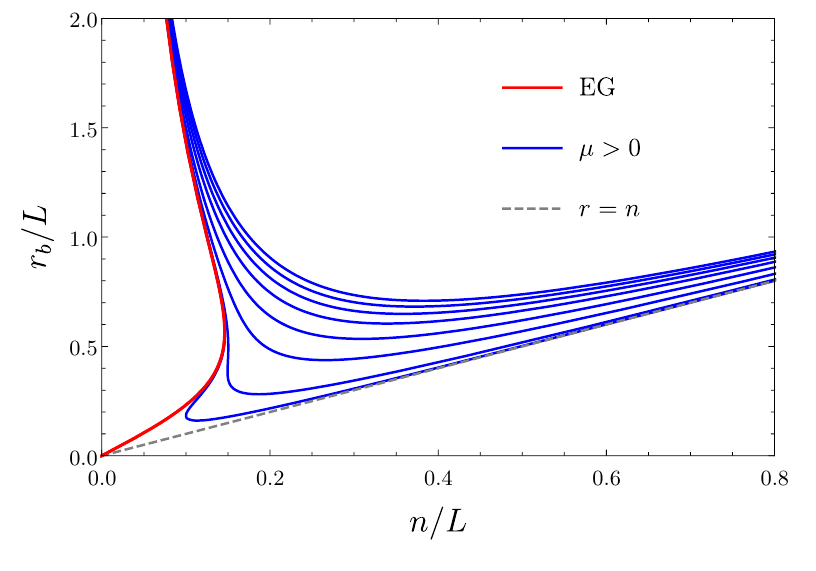
Figure 3 . We show the bolt radius r b for several values of (cid:22) . In red we show the Einstein gravity value ( (cid:22) = 0), and the blue lines correspond to (cid:22) = 0 : 0001 ; 0 : 001126 ; 0 : 01 ; 8 = 270 ; 16 = 270 ; 24 = 270 ; 32 = 270 ; 4 = 27. For any non-vanishing (cid:22) there is at least one solution for every value of n . For large n there is a new solution which approaches r b ! n asymptotically. The gray dashed line corresponds to NUT solutions.